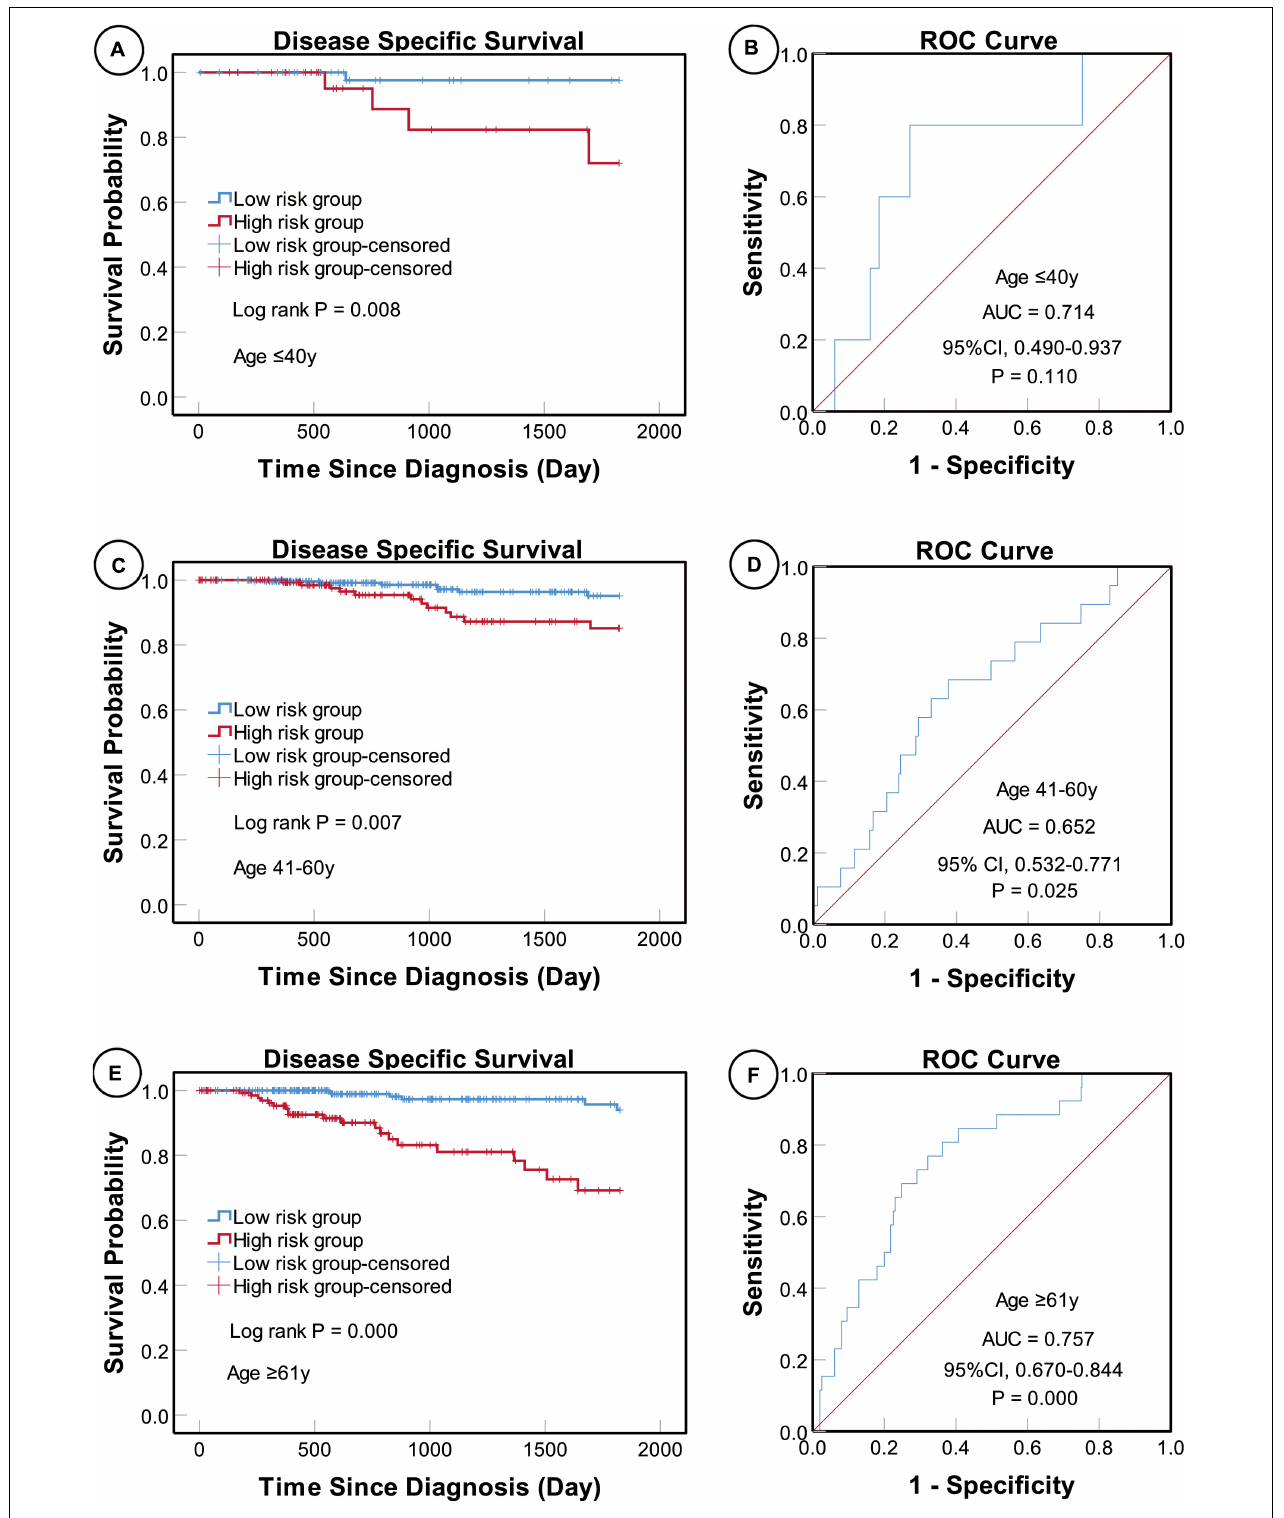
FIGURE 4 | KM and ROC curve analyses of patients stratified by age. KM analysis showed that the patients in low-risk group had significantly better DSS in the ≤ 40 years (A) , 41–61 years (C) , and ≥ 61 years (E) subgroups. ROC analysis showed that the five-miRNA signature exhibited high sensitivity and specificity in predicting the prognosis of patients with BC in the ≤ 40 years (B) , 41–61 years (D) , and ≥ 61 years (F) subgroups.